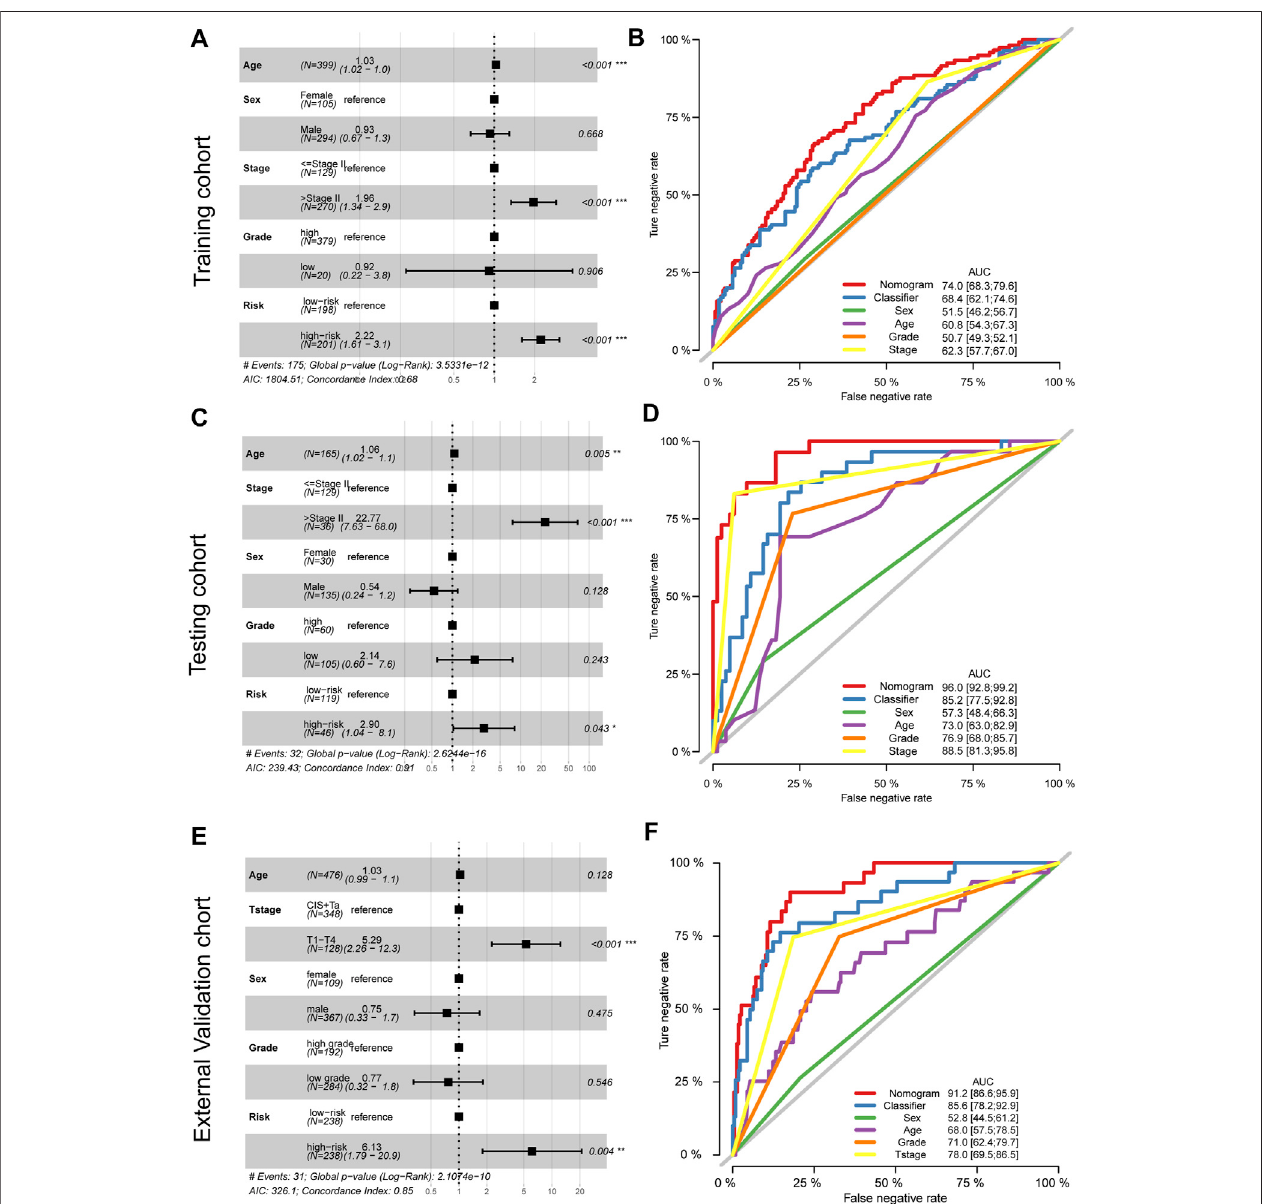
FIGURE 6 | Adjustment and combination of the clinical features with the prognostic signature. Multivariate Cox analysis and forest plot revealed the independent prognosticvalueofthesignatureinthetrainingTCGA-BLCAcohort (A) ,testingGSE13507cohort (C) ,andexternalvalidation cohort (E) .Thecombinationnomogramof the signature and clinical features displays a preferred prognostic value in the training TCGA-BLCA cohort (B) , testing GSE13507 cohort (D) , and external validation cohort (F) .